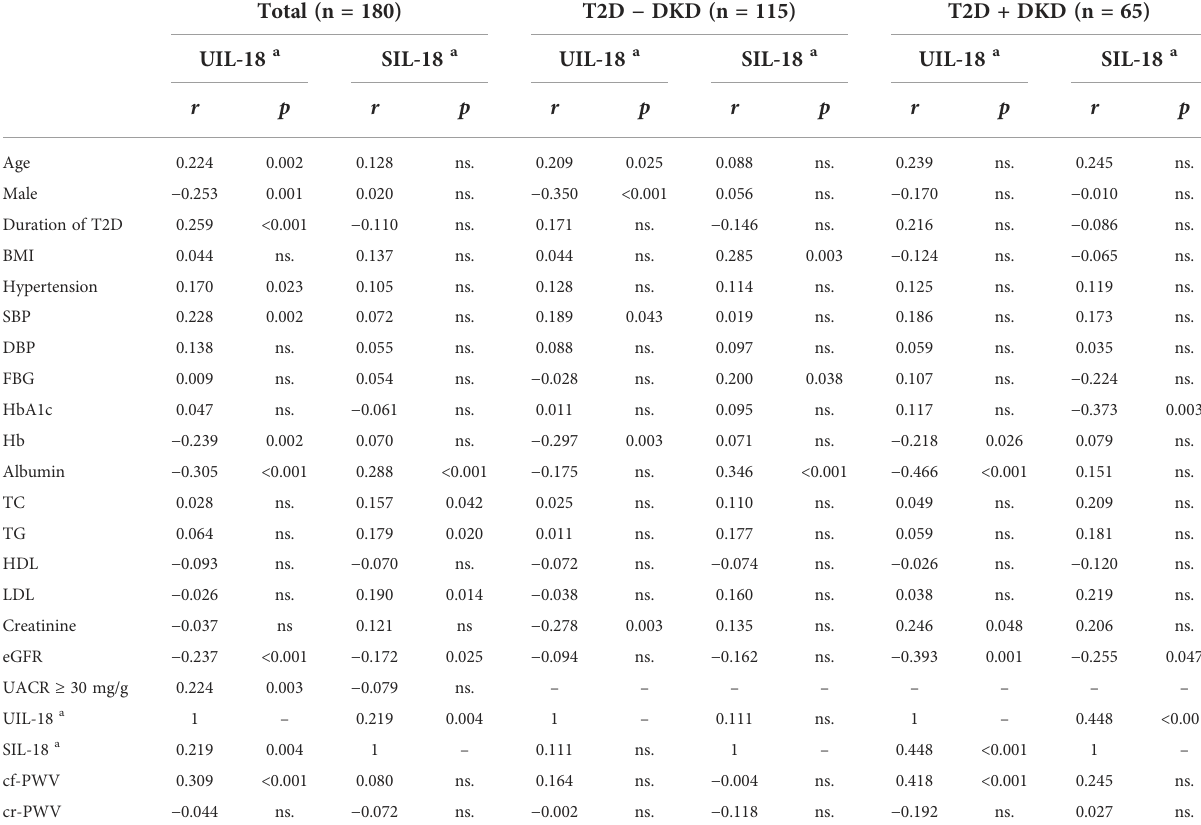
TABLE 2 Univariate analysis of relationship between logarithmic serum or urinary IL-18 levels and characteristics of type 2